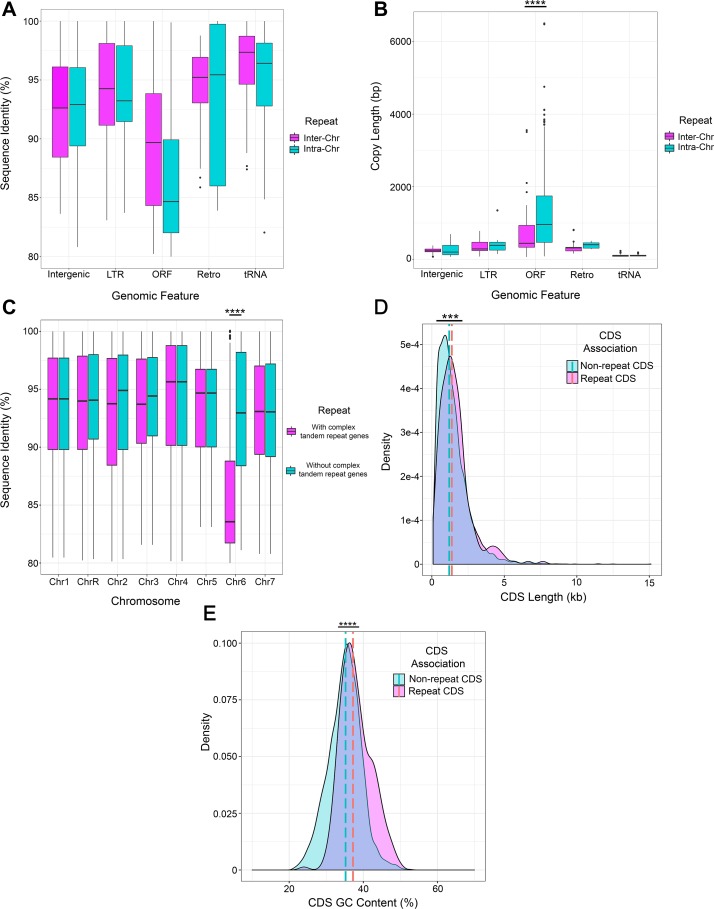
Key features of long repeat sequences in C. albicans.The percent shared identity (A) and repeat copy length (B) of intra-chromosomal (Intra-Chr) or inter-chromosomal (Inter-Chr) repeat matches containing each genomic feature: Intergenic, LTR, ORF (excluding the complex tandem repeat genes), Retrotransposon (Retro), and tRNA (Supplementary file 2). Copy length is significantly different between repeats containing ORFs compared to repeats containing other features (p<0.0001, Kruskal-Wallis with Dunn’s multiple comparisons). (C) Percent sequence identity of repeat matches for each chromosome both before (pink) and after (blue) removal of the complex tandem repeat genes. The median sequence identity of repeats on Chr6 is significantly increased after removal of the complex tandem repeat genes (p<0.0001, Kruskal-Wallis with Dunn’s multiple comparisons). The length (D) and percent GC content (E) of the full-length ORF coding sequences (CDS) within long repeat sequences (pink) and all other full-length CDSs not contained in long repeat sequences (blue). Dashed lines represent median values. The full-length CDSs contained in long repeats are significantly longer (p<0.0008, Kolmogorov-Smirnov test) and have a significantly higher percent GC content (p<0.0001, Kolmogorov-Smirnov test) than all full-length CDSs not contained in long repeat sequences. ***p<0.001, ****p<0.0001 (see Materials and methods, Figure 2—source data 3).